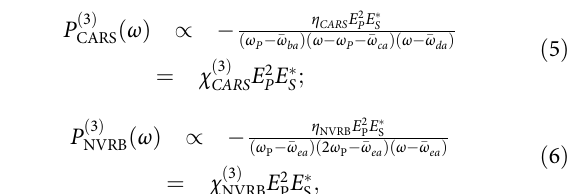
22,48 – 52 . For positive time delays within a few τ , P ð 3 Þ NVRB = P ð 3 Þ P ð 3 Þ is progressively enhanced, as shown in Fig. 4a – c. NVRB CARS Electronically resonant and non-resonant FWM . The system response can be evaluated through a density-matrix descrip-